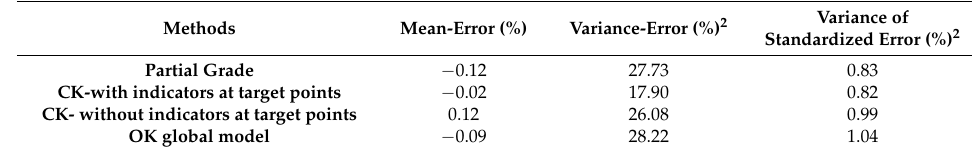
Table 6. Cross-validation using the co-kriging (CK), partial grade (PG) and ordinary kriging (OK)-global models.